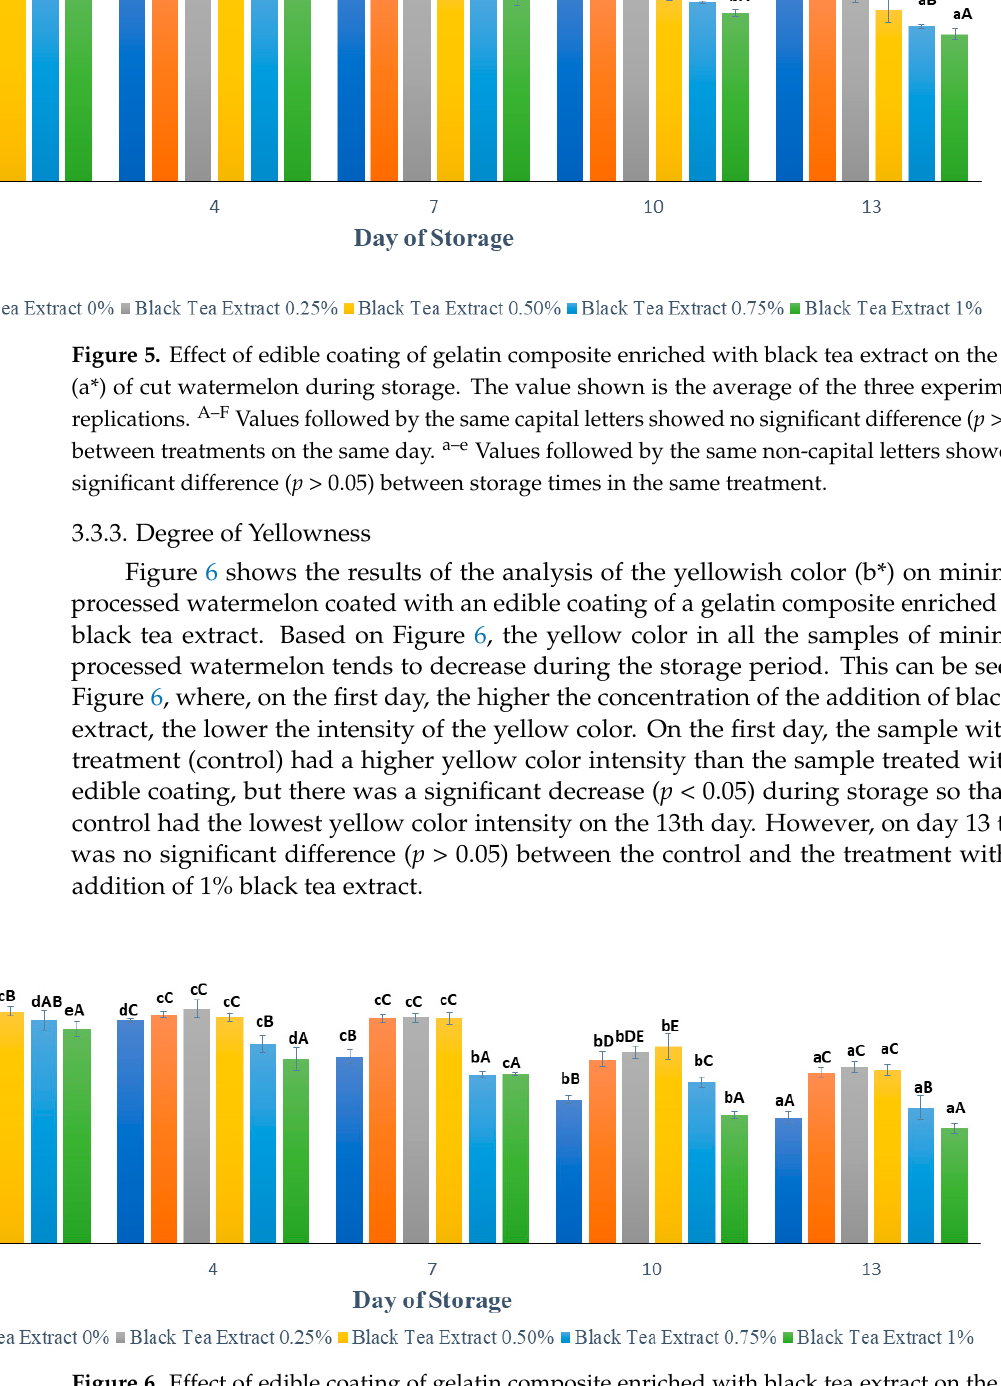
Figure 6. Effect of edible coating of gelatin composite enriched with black tea extract on the color (b*) of minimally processed watermelon during storage. The value shown is the average of the three experimental replications. A–E Values followed by the same capital letters showed no significant difference ( p > 0.05) between treatments on the same day. a–e Values followed by the same non-capital letters showed no significant difference ( p > 0.05) between storage times in the same treatment.